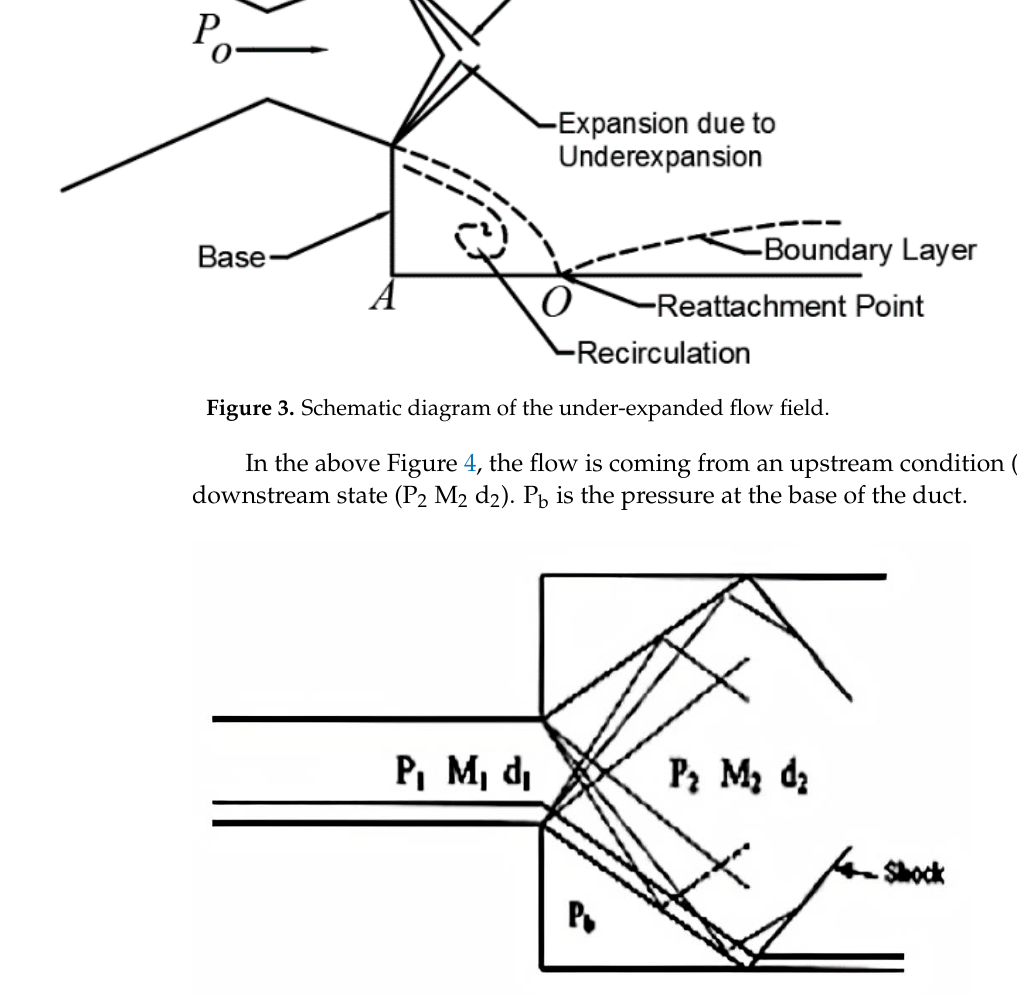
Figure 4. Schematic diagram of internal